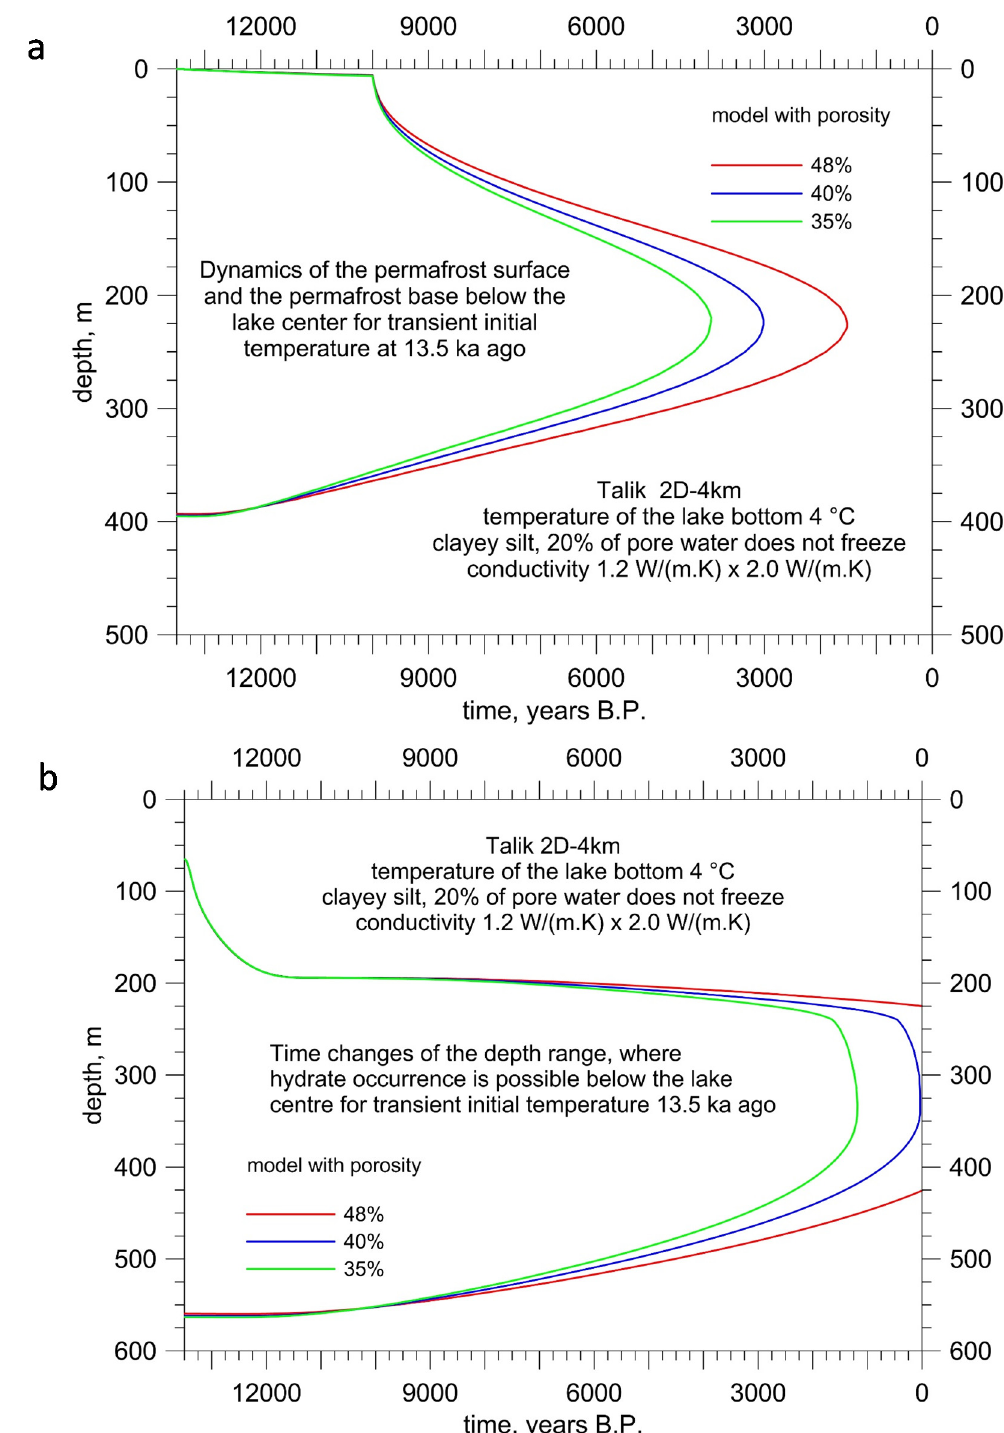
Figure 11. Influence of porosity upon permafrost ( a ) and GH stabilities ( b ) over